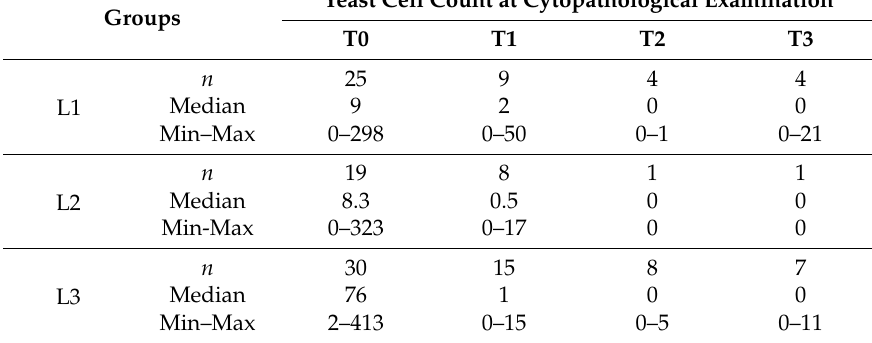
Table 2. Assessment of fungal burden at the cytopathological examination according to the distribution of lesions in cats with sporotrichosis during treatment with itraconazole, Lapclin-Dermzoo/INI/ Fiocruz